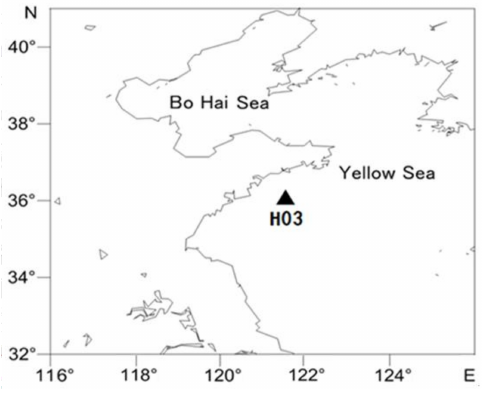
Figure 1. Incubation